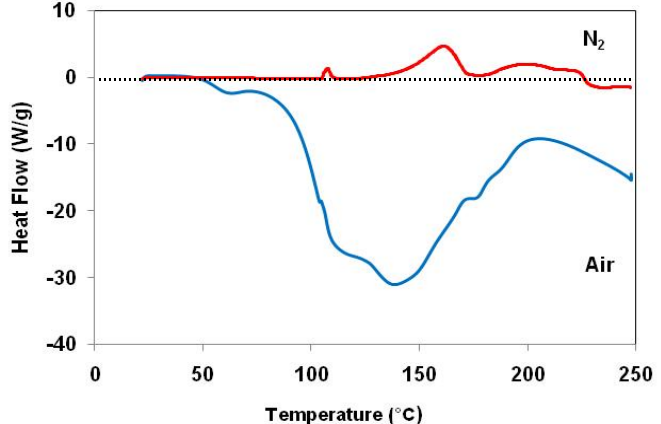
][AuFe (CO) ] ( ─ ) in air and ( ─ ) under nitrogen. 4 4 16